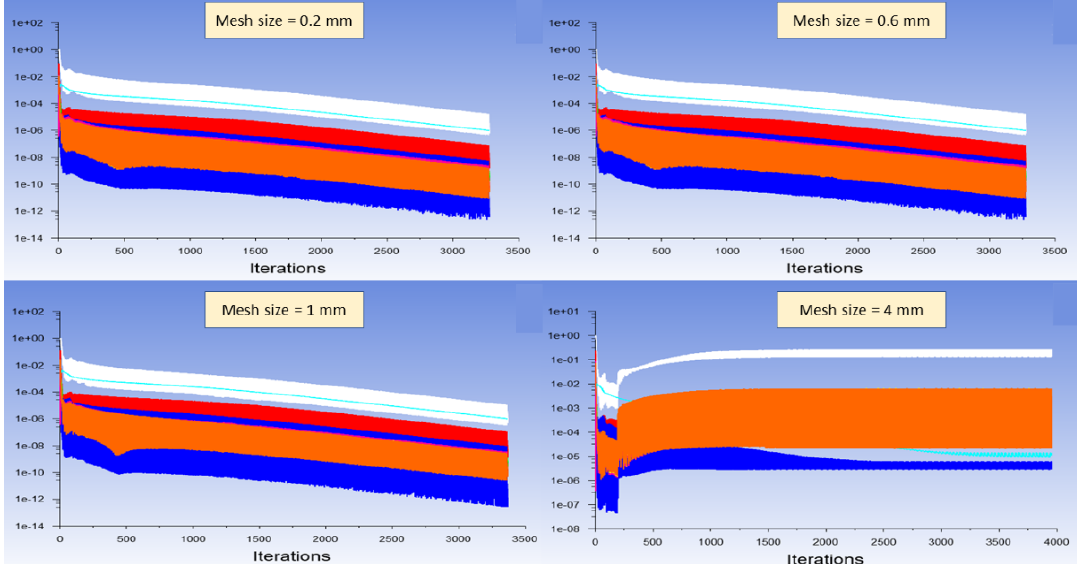
Figure 4. Residuals of the Fluent solver for different meshing sizes. (white: continuity, red: x-velocity, green: y-velocity, dark blue: energy, light blue: density, pink: CH 4 mass balance, yellow: H 2 mass balance, orange: C mass balance).